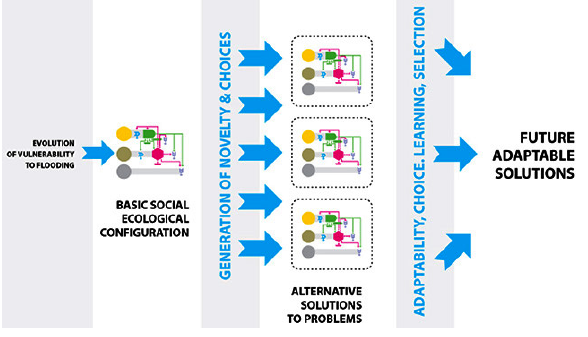
Fig. 4 . Diagram of a basic social-ecological unit (top) and how in a dynamic urban system selection based on multiple such units can lead to learning and adaptation. The diagram is based on the adaptation to flooding in the city. Multiple alternative solutions are generated but few prove adaptable. The text contains